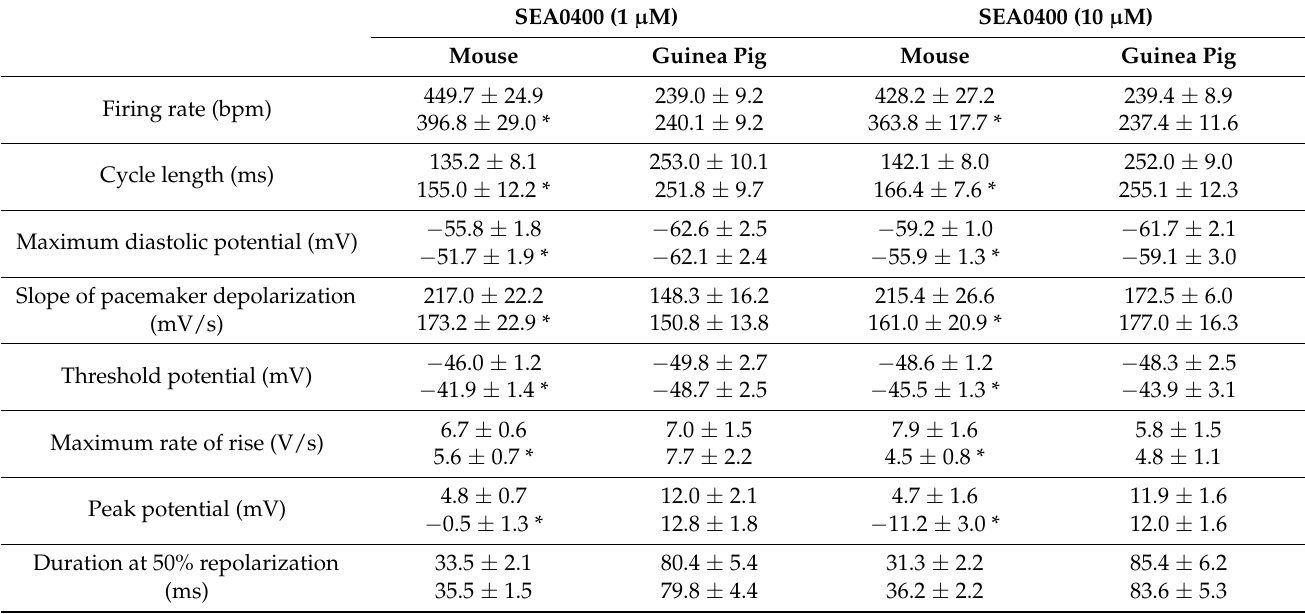
Figure 2. Effect of SEA0400 on the sinus node action potential of the mouse and guinea pig. Typical traces before (black lines) and after (red lines) application of 1 µ M (upper) and 10 µ M (lower). Table 2. Action potential parameters before and after application of SEA0400.